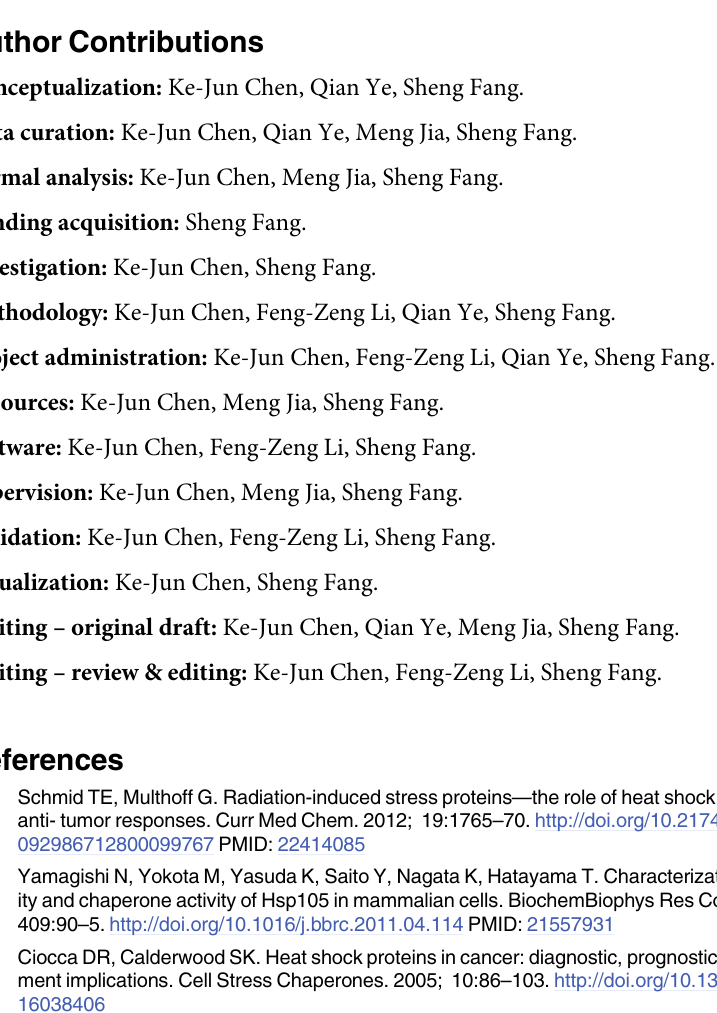
S1 Fig. The western blot of HSP105 expression in skin tumors. We compared the expression of HSP105 in skin tumors, of which line 2 was CMM, line3 and 4 was nevi.